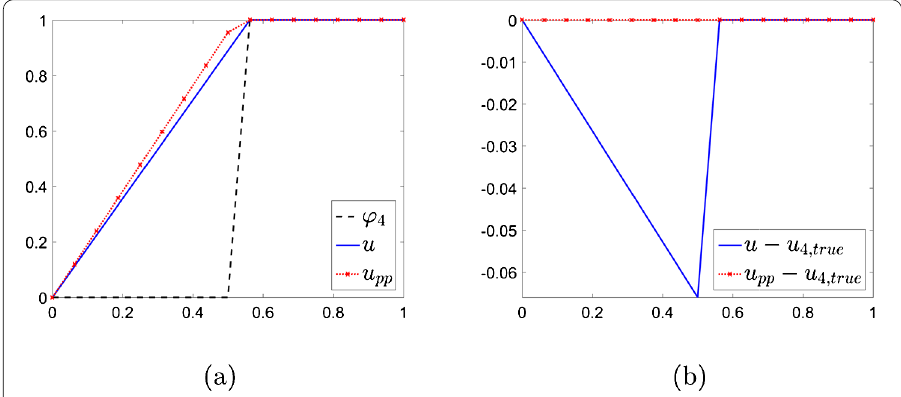
Figure 10 The post-processing algorithm applied for an obstacle problem in 1D at resolution 16. (a) The computed solutions without the post-process (blue solid curve) and with the post-process (red dotted curve with × marks) and (b) their errors. Here the subscript pp indicates the